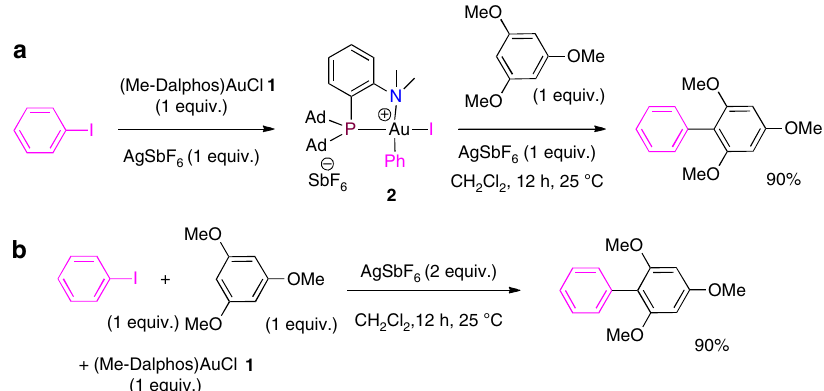
Fig. 6 Cross-coupling of iodobenzene and 1,3,5-trimethoxybenzene with 1/AgSbF 6. a Sequential addition of reagents. b